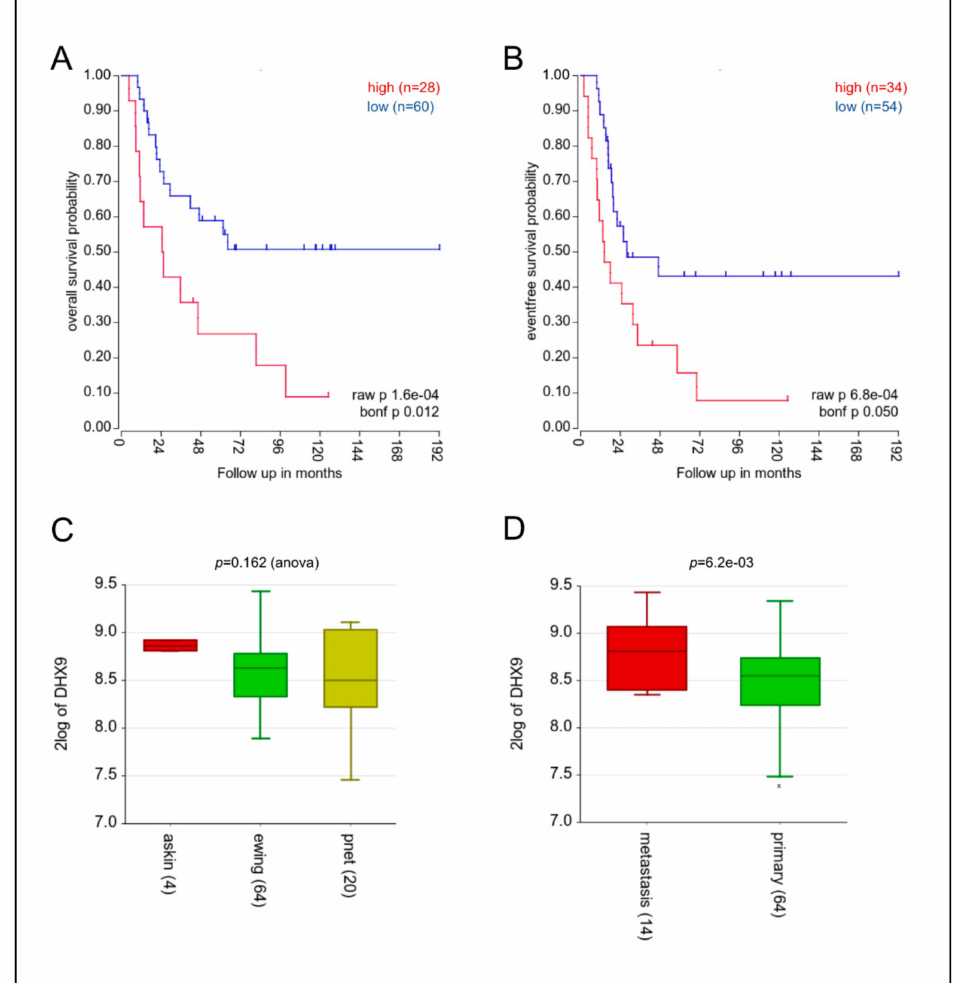
Figure 1. DHX9 expression is a prognostic factor for Ewing sarcoma malignancy. Kaplan–Meier plots of overall ( A ) and event-free survival ( B ) probabilities generated by gene expression profiling ([25]; GSE17679) in R2 Genomics (https: // hgserver1.amc.nl / cgi-bin / r2 / main.cgi). The dataset analyzed